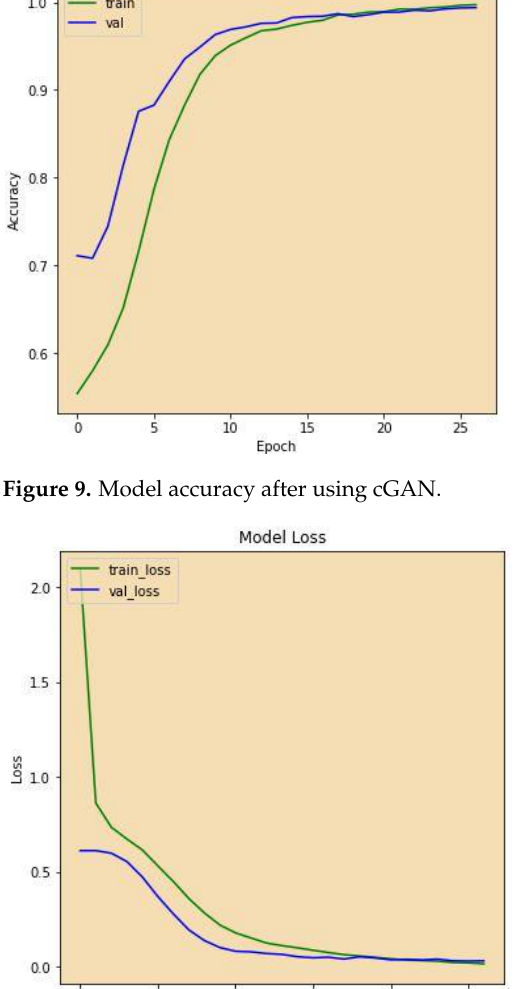
Figure 8. Model loss before using cGAN.